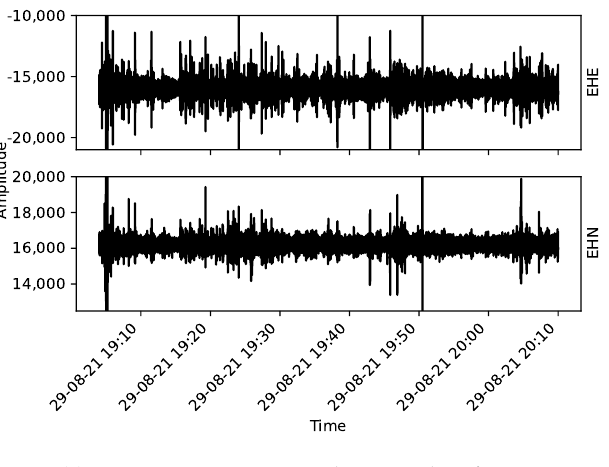
( c ) Heterogeneous Dam with Water Flow for Sensor AM.R7D9F. Figure 5. Collected data for sensor AM.R7D9F. From ( a – c ) the three monitoring stages are presented: homogeneous dam, heterogeneous dam without flow and heterogeneous dam with flow,